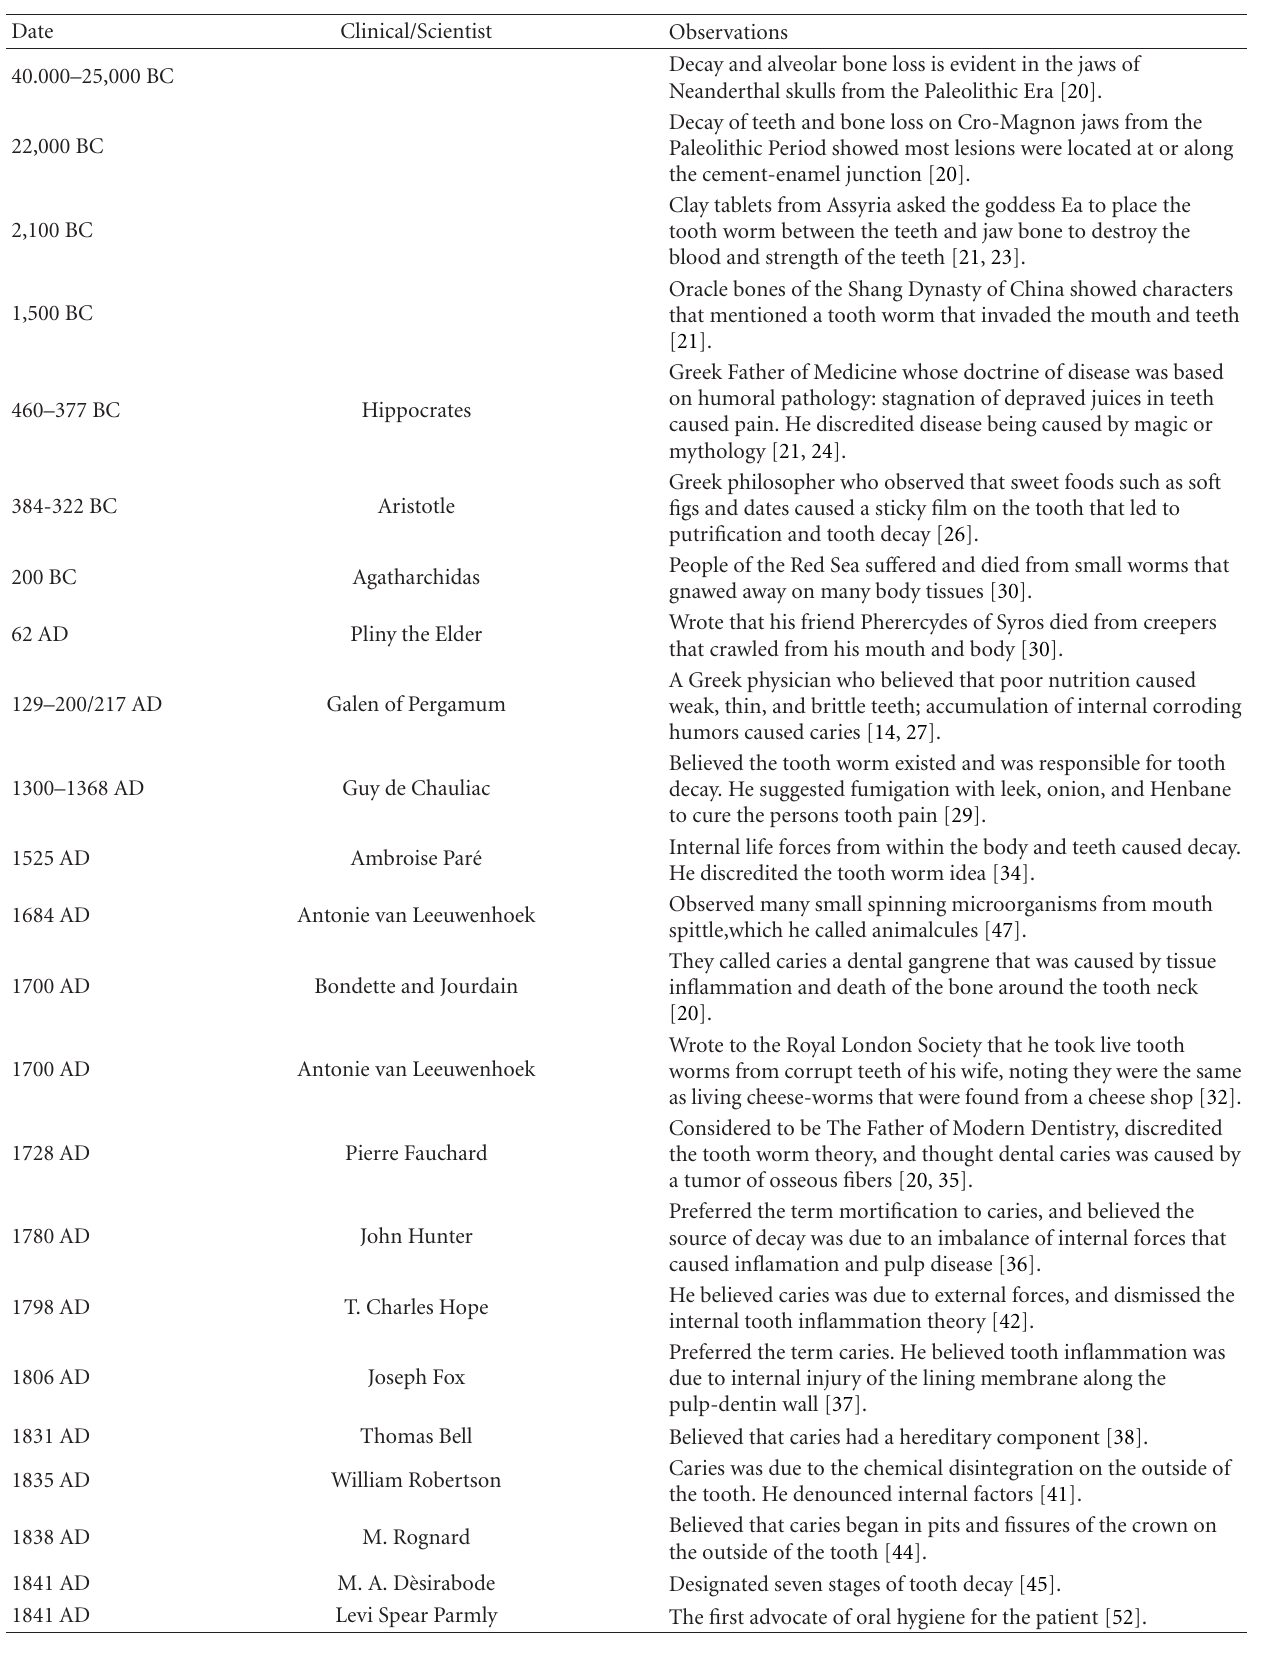
Table 1: The caries phenomenon